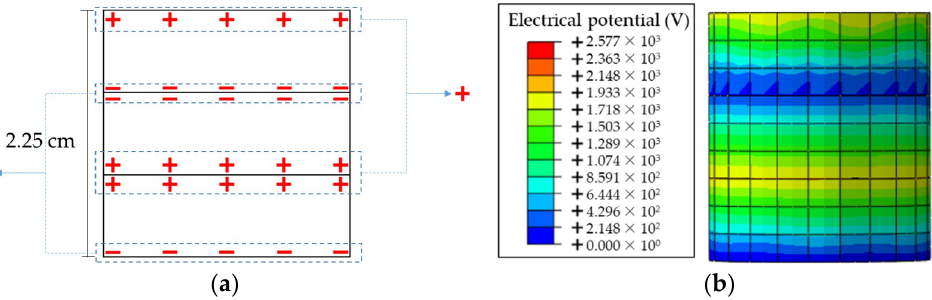
Figure 4. Piezoelectric unit used in this study: ( a ) Structure of piezoelectric unit; ( b ) Example of computational result. Table 1. Basic parameters for PZT-5H.